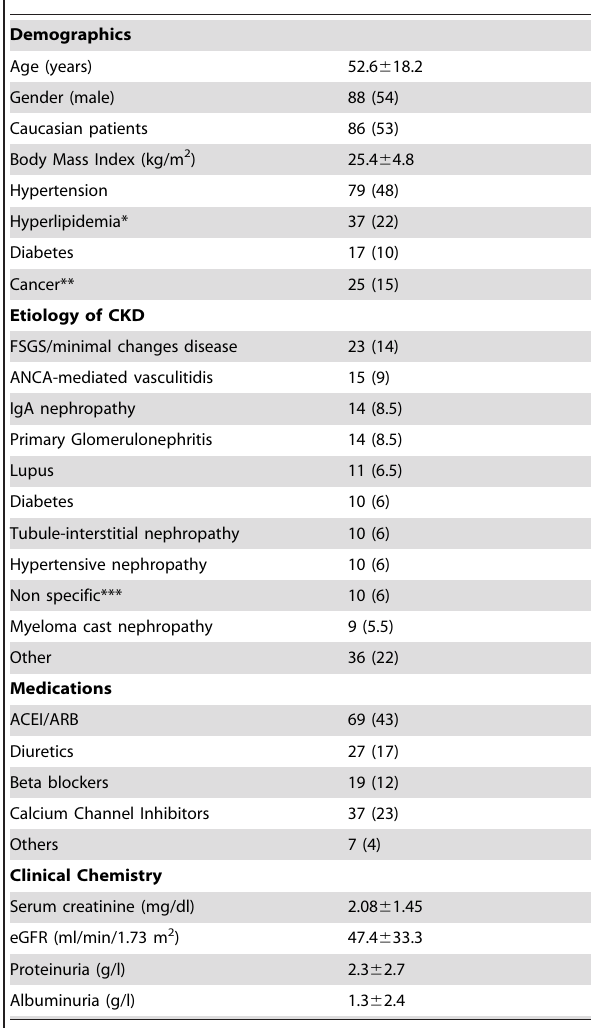
Table 1. Baseline characteristics of the study cohort